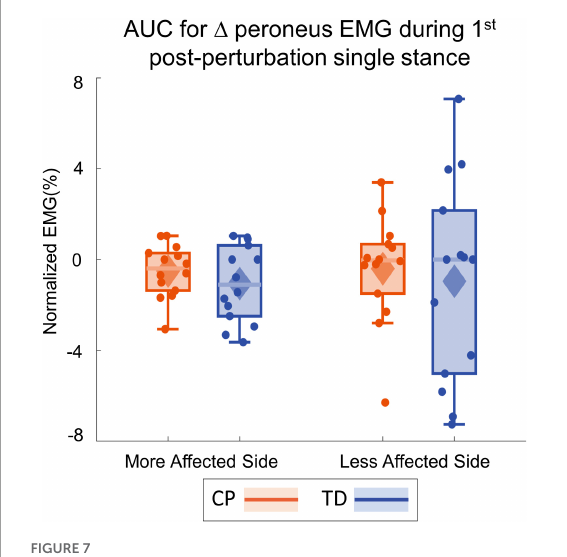
FIGURE7 Box and whisker plots, with scattered dots indicating each subject, for AUC (cid:49) peroneus EMG for CP (orange) and TD (blue) groups on the more affected (left) and less affected (right) side.